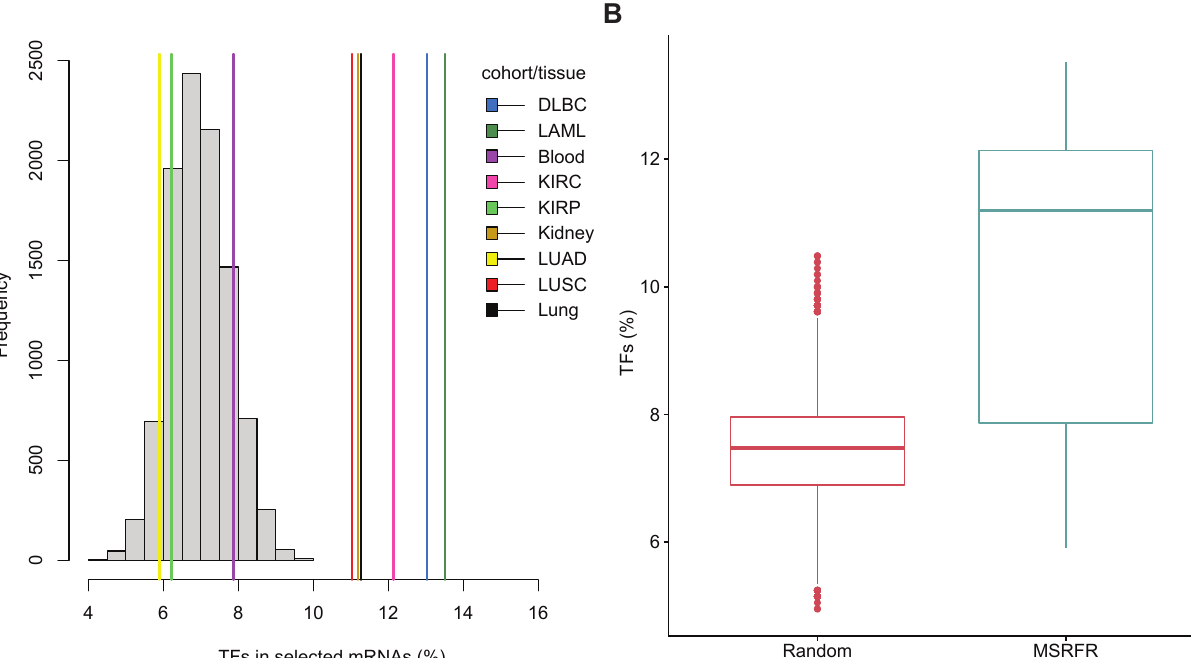
Figure 8. ( A ) Histogram of TFs that are present in each investigated primary tumors and their shared tissue-specific overlaps (blood, kidney, lung). Grey bars represent randomized results of 10,000 gene lists, and colored lines show average TFs in key regulatory modules identified by MSRFR. ( B ) Box plot of the average TFs detected by MSRFR vs. identified in random gene